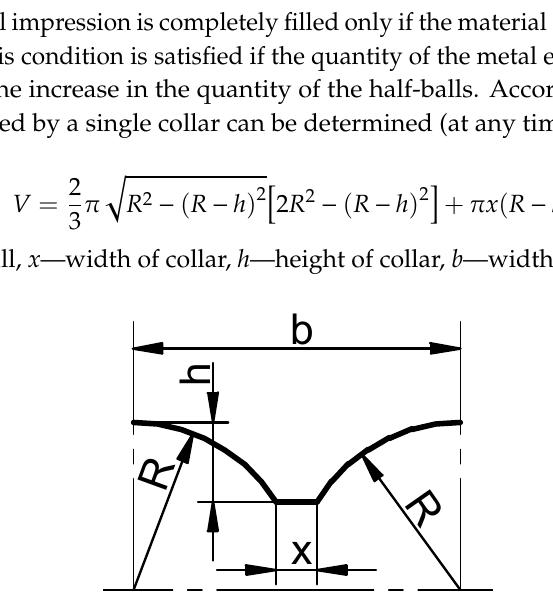
Figure 5. Profile of the roll collar used to calculate the tool geometry.